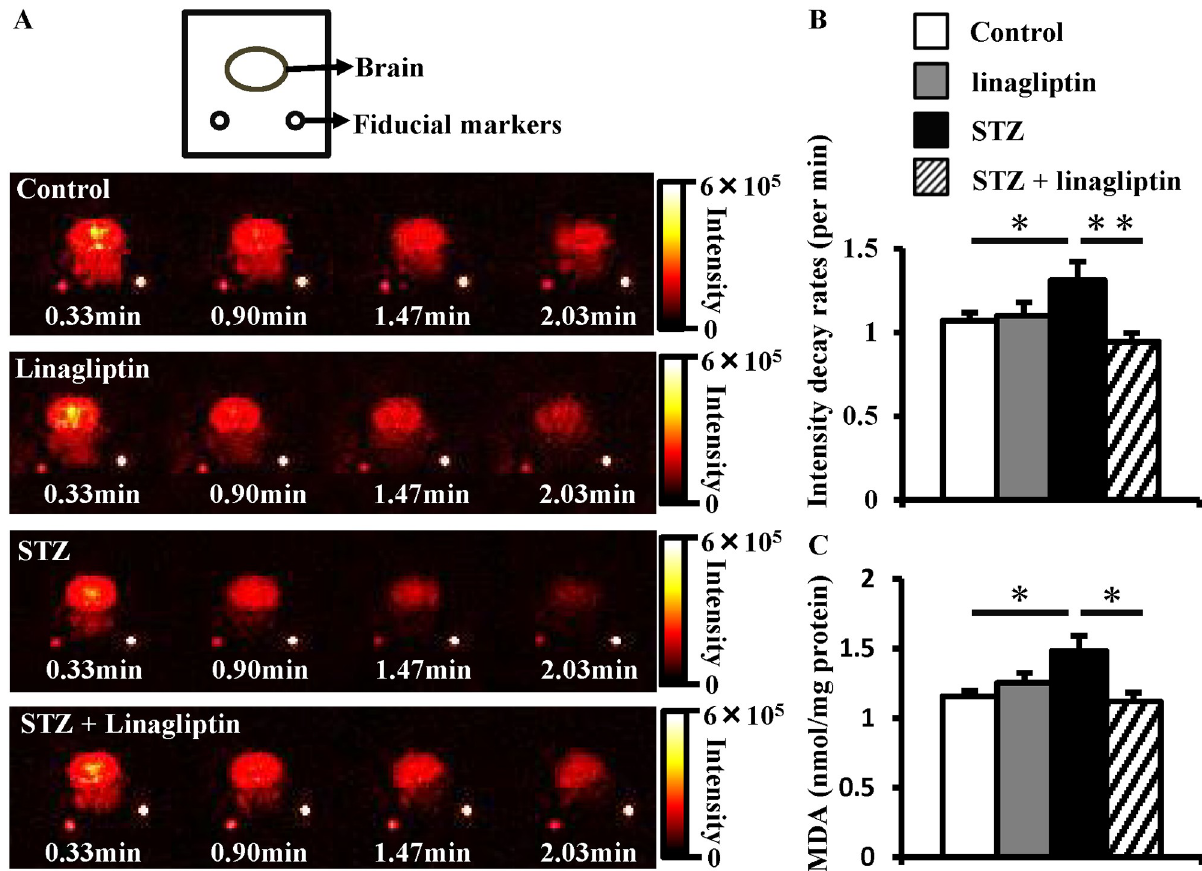
Fig 3. Effect of linagliptin on oxidative stress in the brain. (A) Time-dependent DNP-MRI images of methoxycarbonyl-PROXYL in the head region. (B) The signal intensity decay rates of methoxycarbonyl-PROXYL in the brain. (C) Malondialdehyde (MDA) levels measured using the thiobarbituric acid-reactive substances (TBARS) assay in whole brain homogenates. Bars represent means ± SEM. Control mice (n = 5); linagliptin-treated control mice (n = 4); diabetic mice (n = 6); linagliptin-treated diabetic mice (n = 8). � P < 0.05, �� P < 0.01.